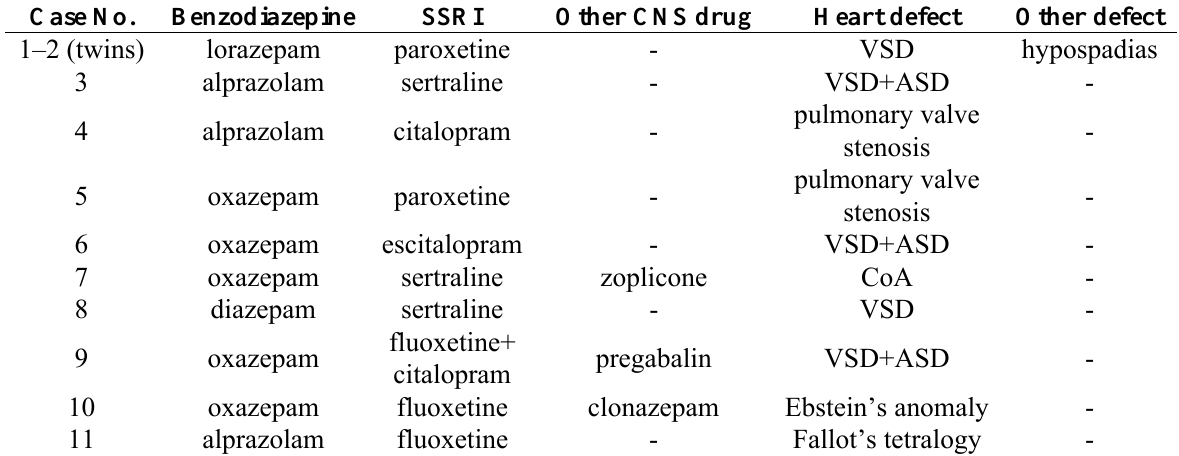
Table 43. Eleven cases with cardiovascular defects after maternal use of benzodiazepines and SSRI. Case No.